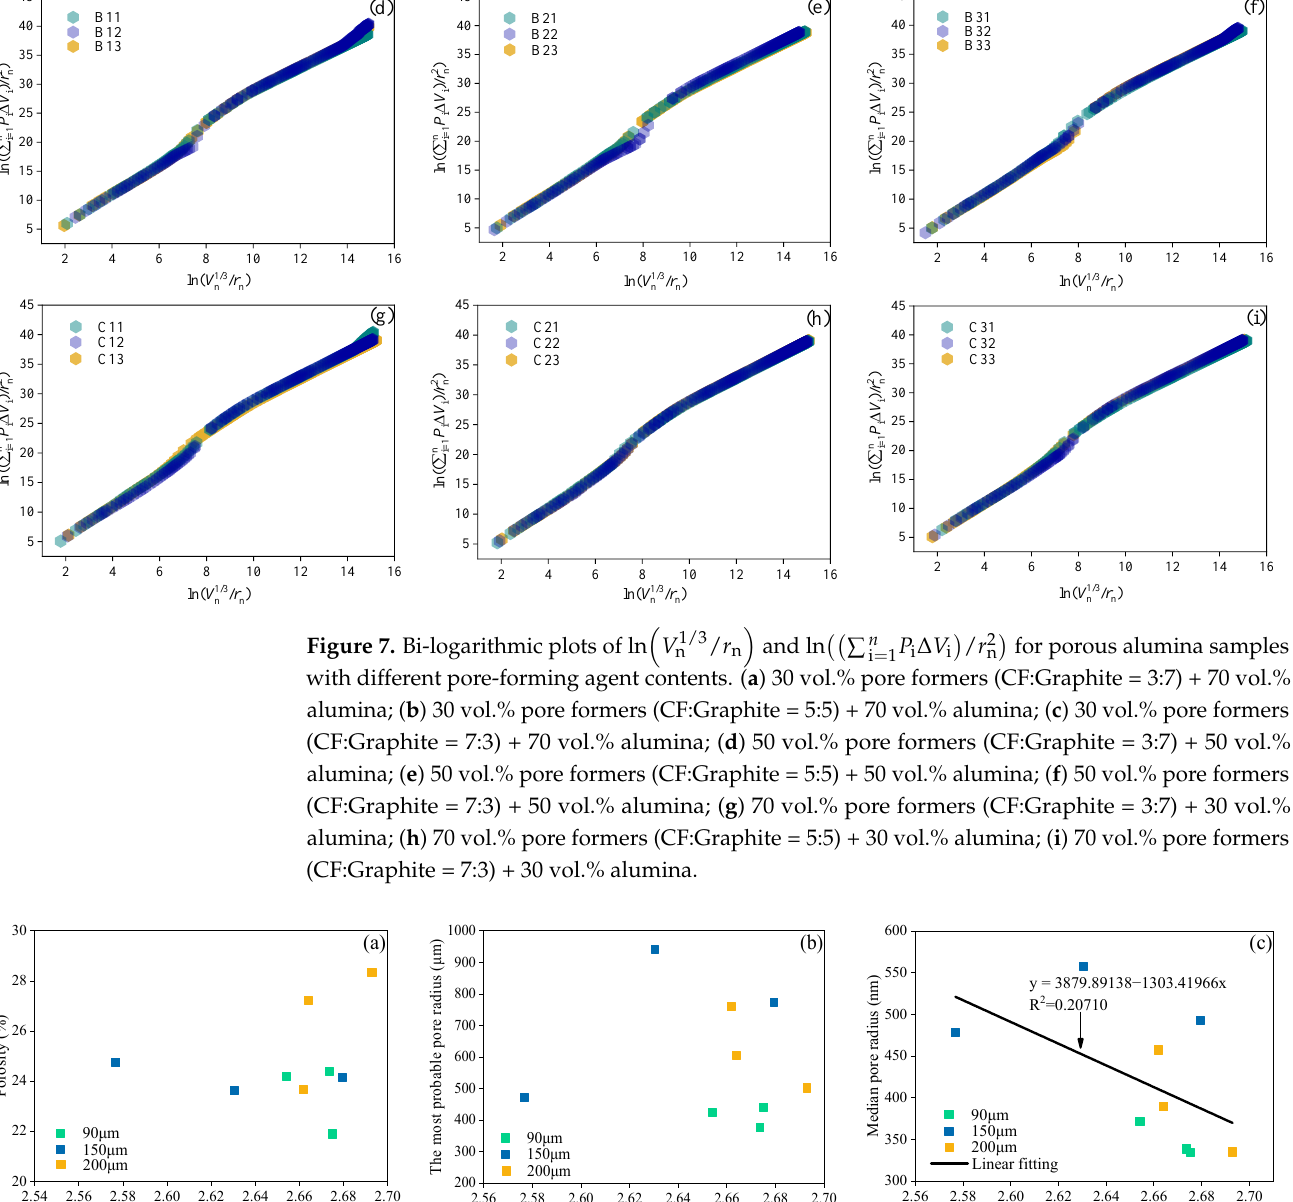
Figure 9. Relationship between D s and ( a ) porosity, ( b ) the most probable pore size, and ( c ) median pore radius for porous alumina samples with 50 vol.% pore-forming agents. The relationships between the D s and porosity, most probable pore size and median pore size of the samples with 70 vol.% pore-forming agents are shown in Figure 10. The